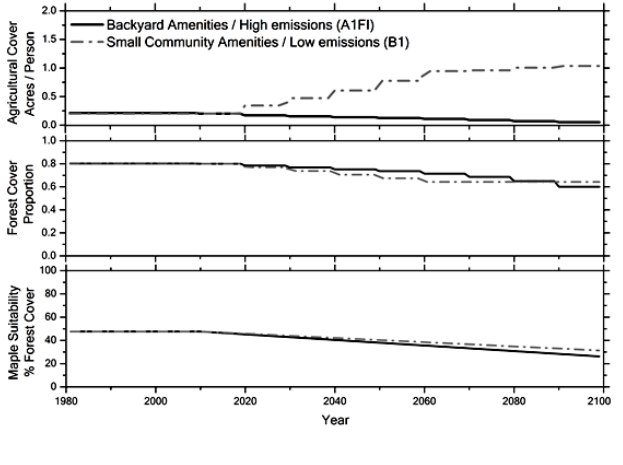
Fig. 4. Time series of land environmental indicators for Backyard Amenities / High Emissions and Small Community Amenities / Low Emission scenarios through 2100 for (a) Agricultural Cover (acres/person), (b) Forest Cover (proportion), and (c) Maple Suitability (% forest